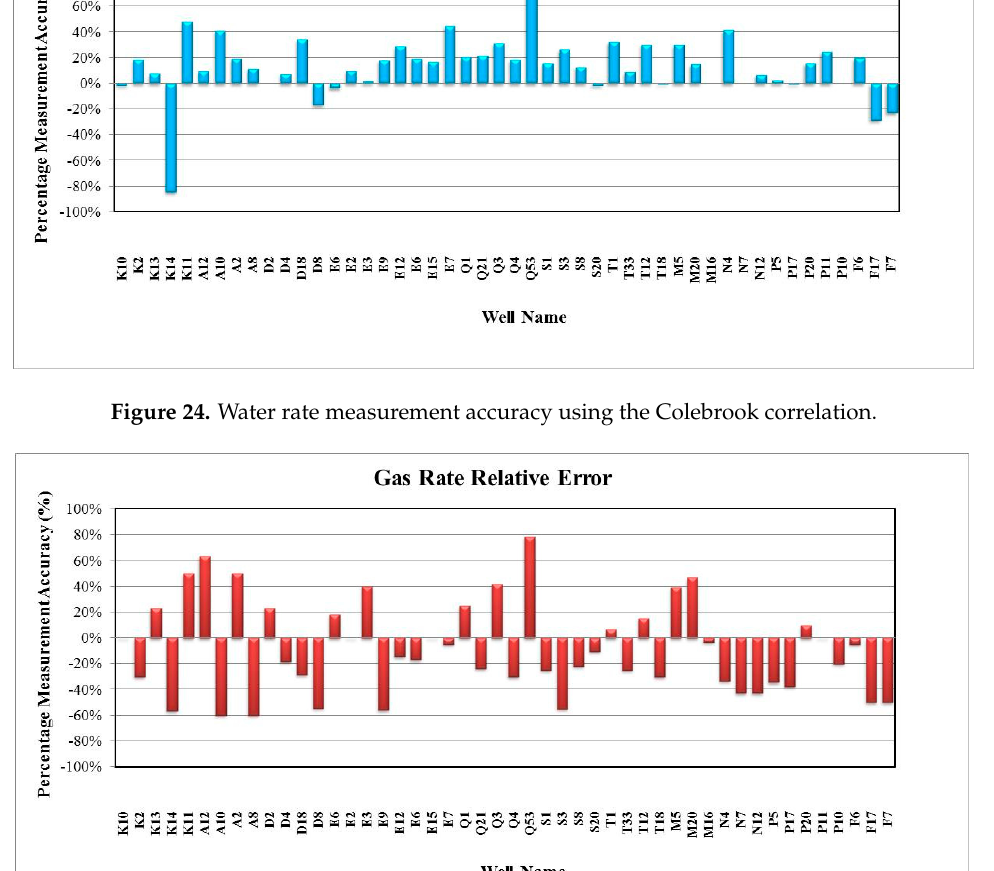
Figure 25. Gas rate measurement accuracy using the Colebrook correlation.